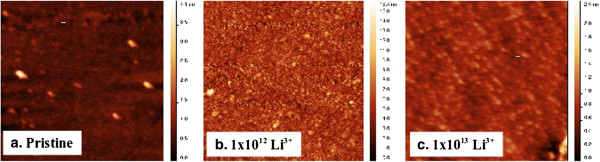
AFM images showing 1-μm scans of the topography of pristine and Li3+-irradiated samples, with increasing fluence. (a) Pristine, (b) 1 × 1012 ions/cm2, and (c) 1 × 1013 ions/cm2.